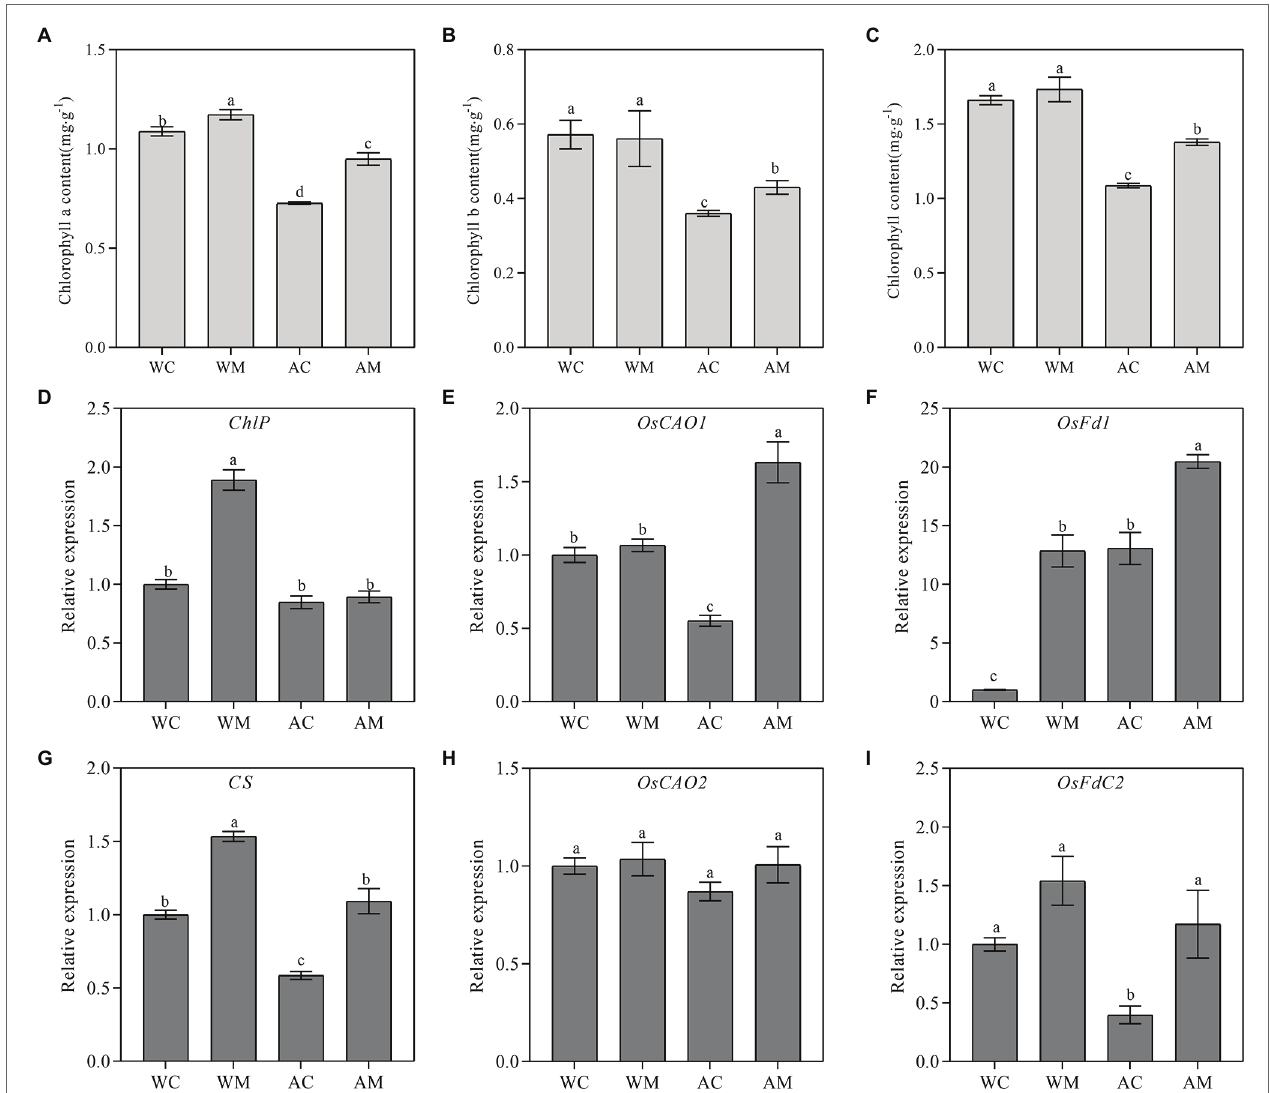
FIGURE 2 | Effects of exogenous MT on chlorophyll content and chlorophyll synthesis-related genes. (A) Chlorophyll a ; (B) Chlorophyll b ; (C) Chlorophyll; and (D–I) Chlorophyll synthesis genes. Data represent means ± SEs of three replicate samples. Different letters denote significant differences ( n = 3, and p < 0.05). WC, control; WM, control pretreated with MT; AC, alkaline stress; and AM, alkaline-stressed plants pretreated with